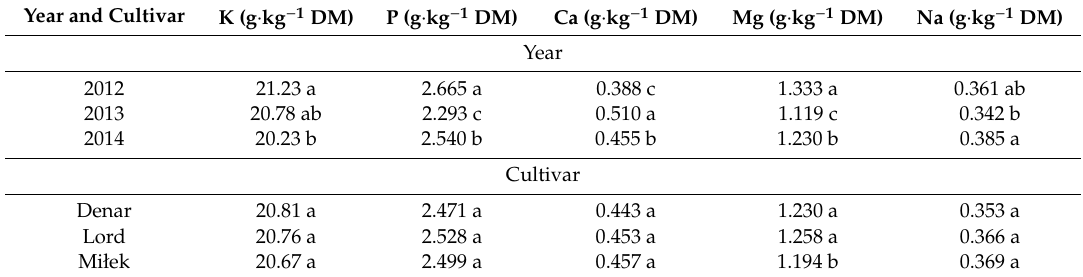
Table 4. Macronutrient content in potato tubers in relation to potato growing season and